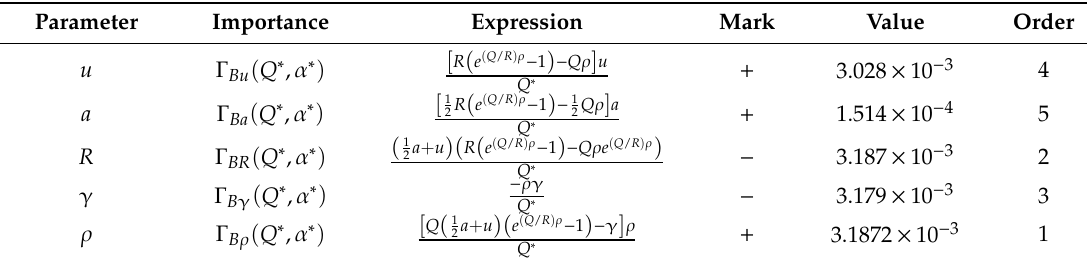
Table 3. Analysis results of Birnbaum importance measure.